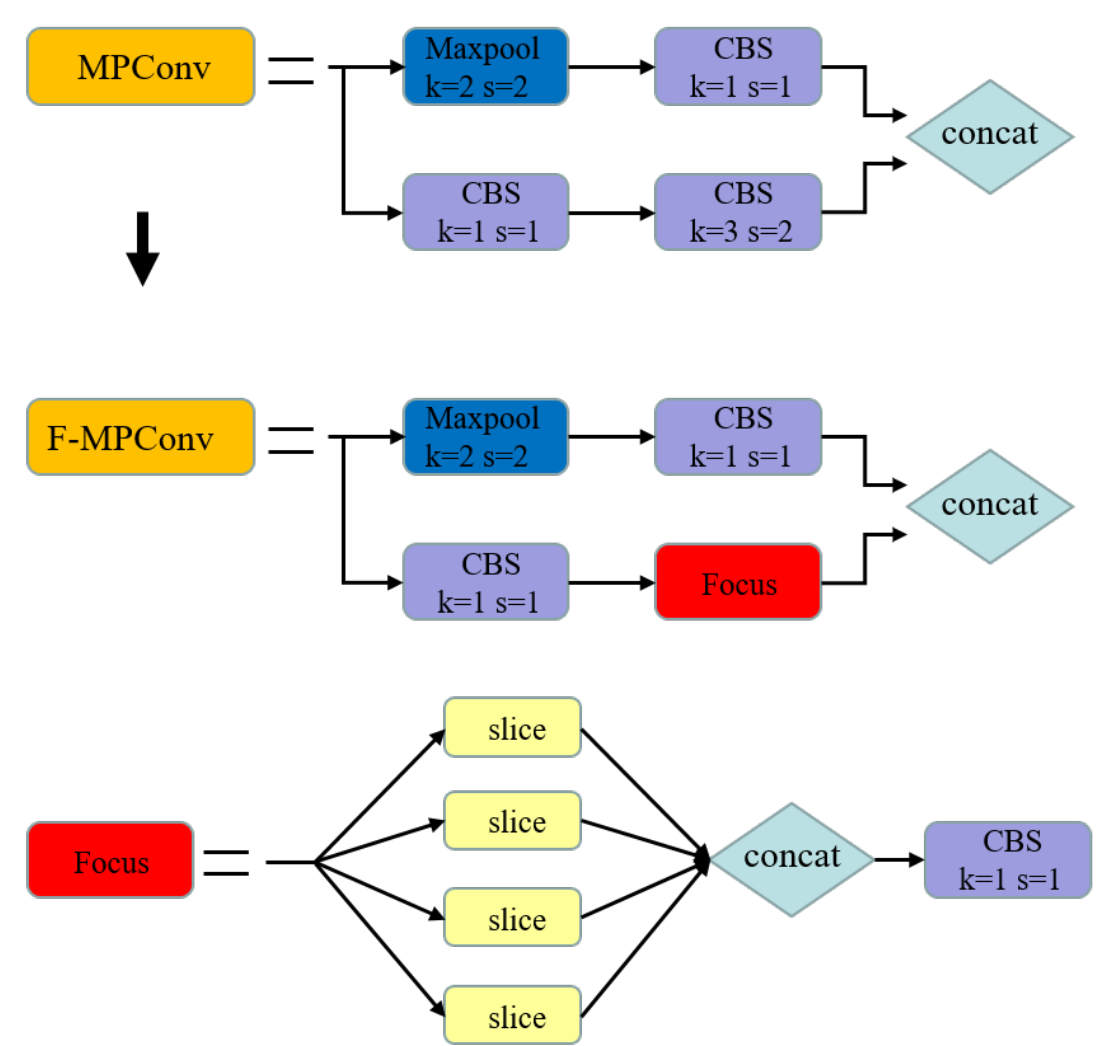
Figure 7. Schematic diagram of the MPConv improvement.